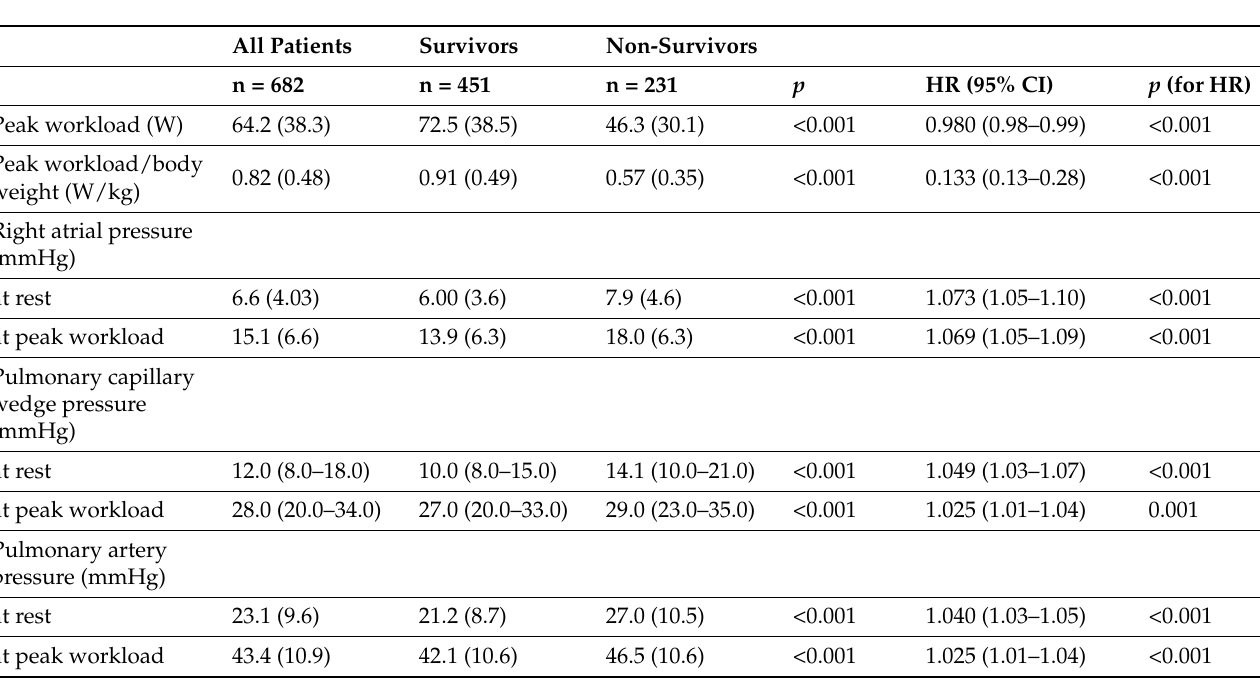
Table 2. Resting and exercise hemodynamics in survivors and non-survivors and respective hazard ratios